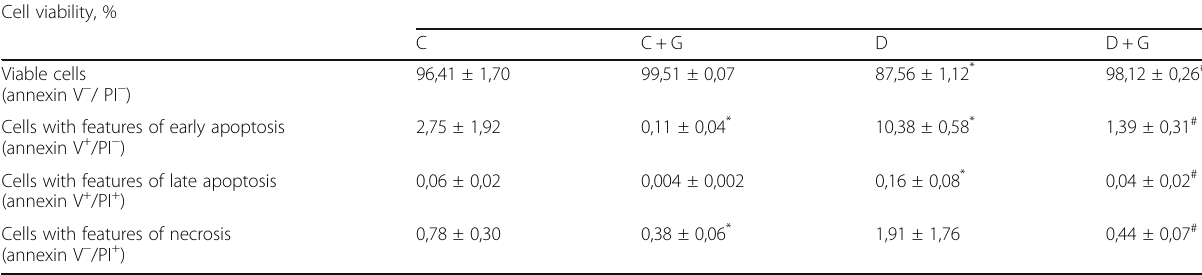
Table 3 Apoptotic lymphocytes detection by binding the surface of cells with annexin V and staining with PI under the administration of Galega officinalis extract in normal conditions and under experimental diabetes mellitus Cell viability, % C C +